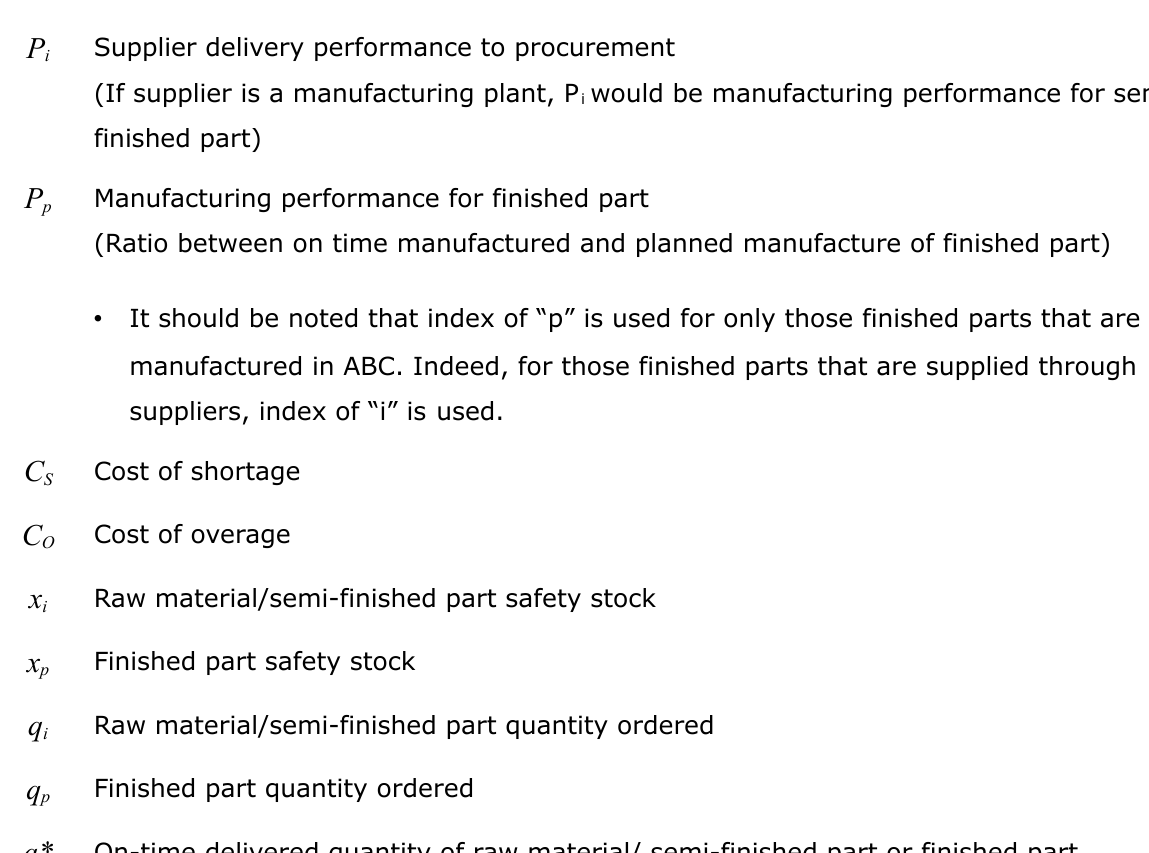
to the customer in the case